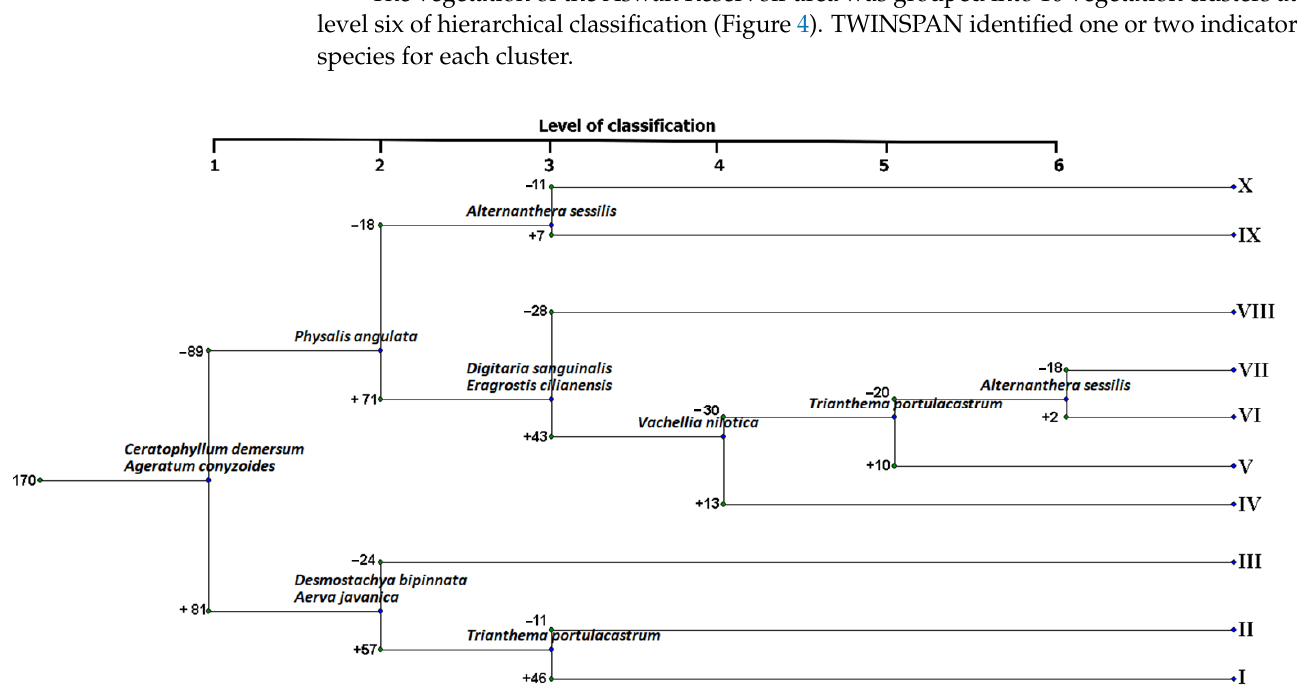
Figure 4. The dendrogram resulting from the application of TWINSPAN on the 27 sampled vegetation stands. The clusters were characterized and named after the dominant and subdominant species as follows: (I) Phragmites australis – Caroxylon imbricatum (stands of High Dam Col-